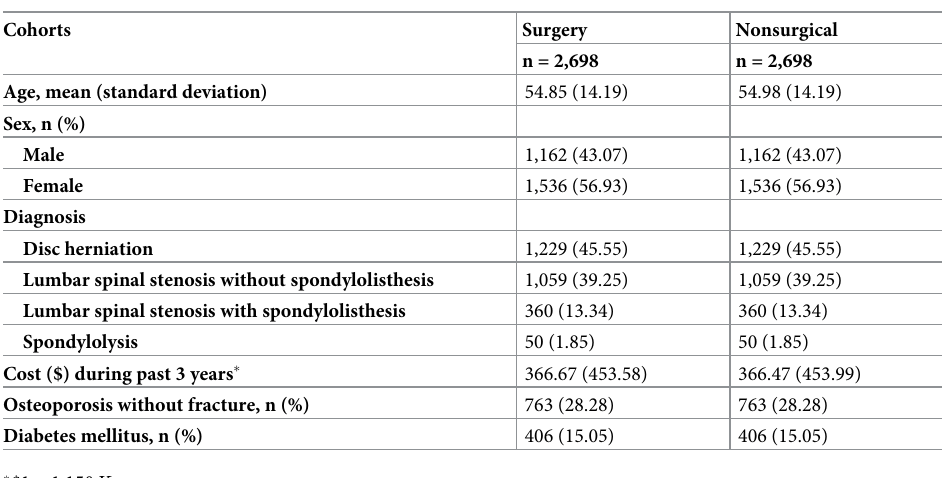
Table 1. Characteristics of the